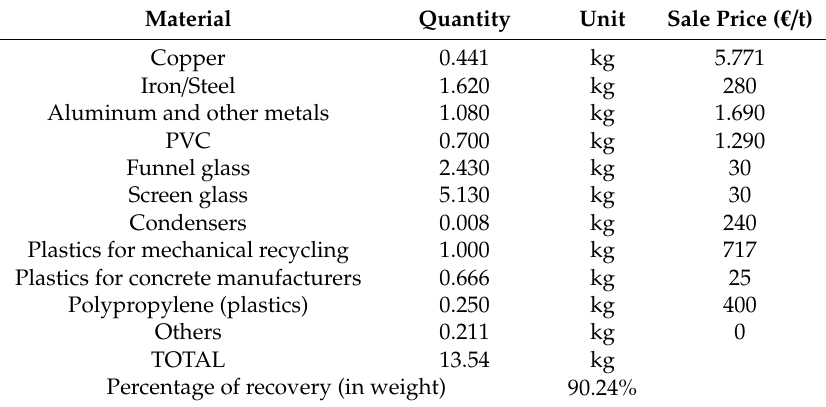
Table 3. Recovered material (in a device with an average weight of 15